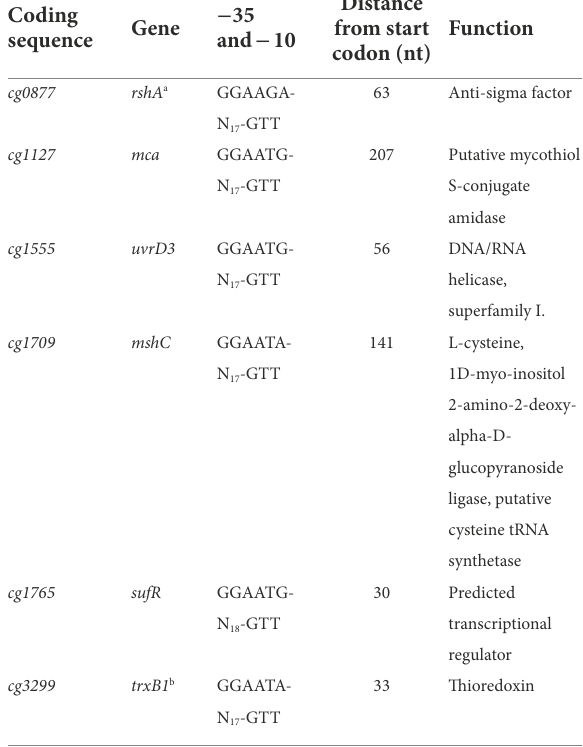
TABLE 3 Exclusively σ H -specific genes and corresponding promoter sequence motifs − 35 and − 10 confirmed by in vivo and in vitro